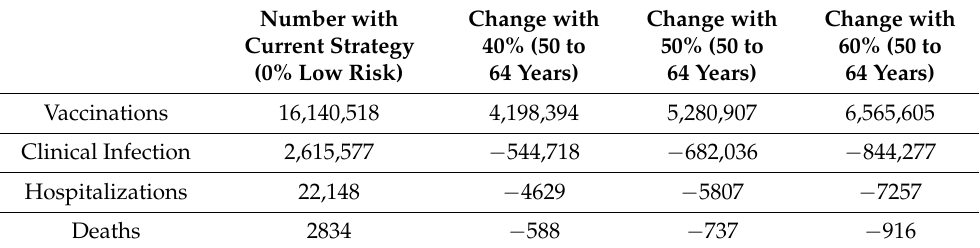
Table 3. Base case results: the average annual change in clinical cases when low risk individuals ages 50 to 64 years old are vaccinated, by coverage level. Number